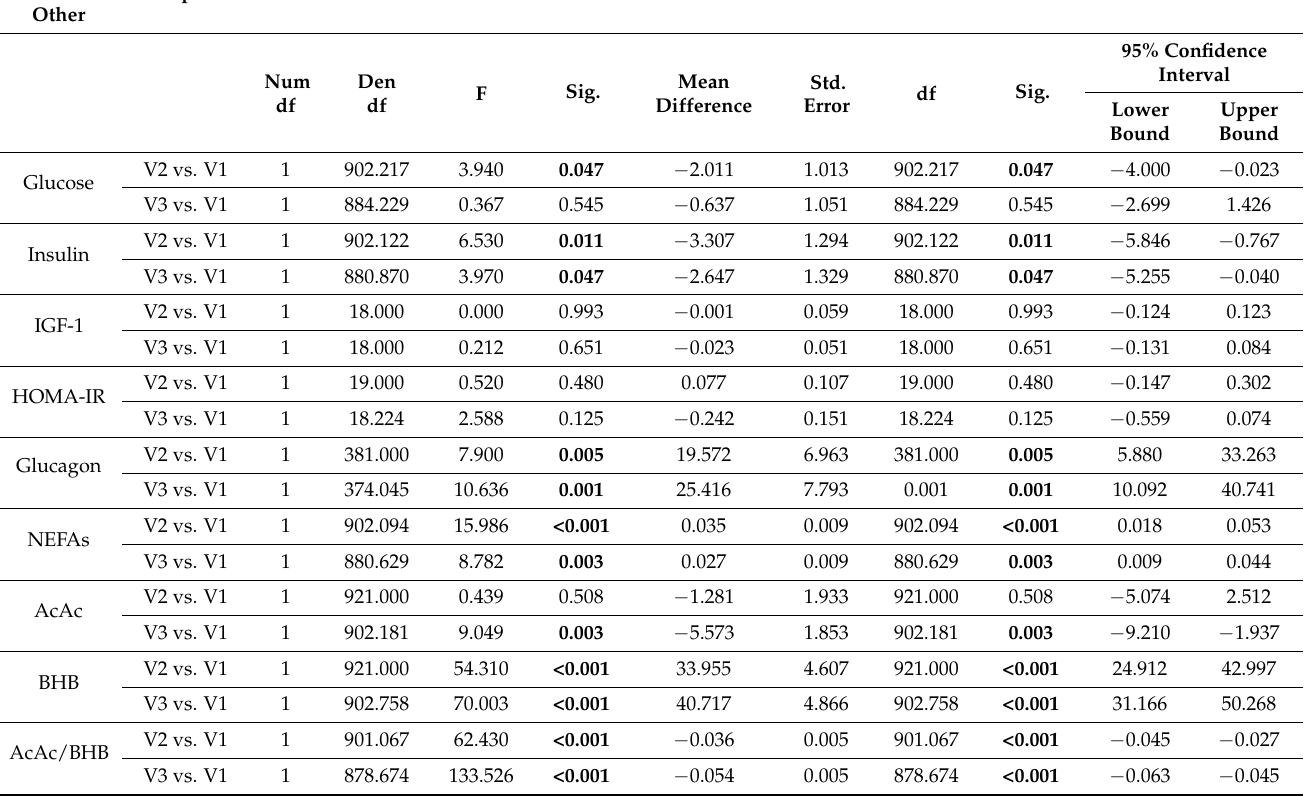
Table 2. Serum metabolites and plasma hormones measured in 34-h periods at baseline (V1), after one dose (V2), and after multiple (V3) empagliflozin